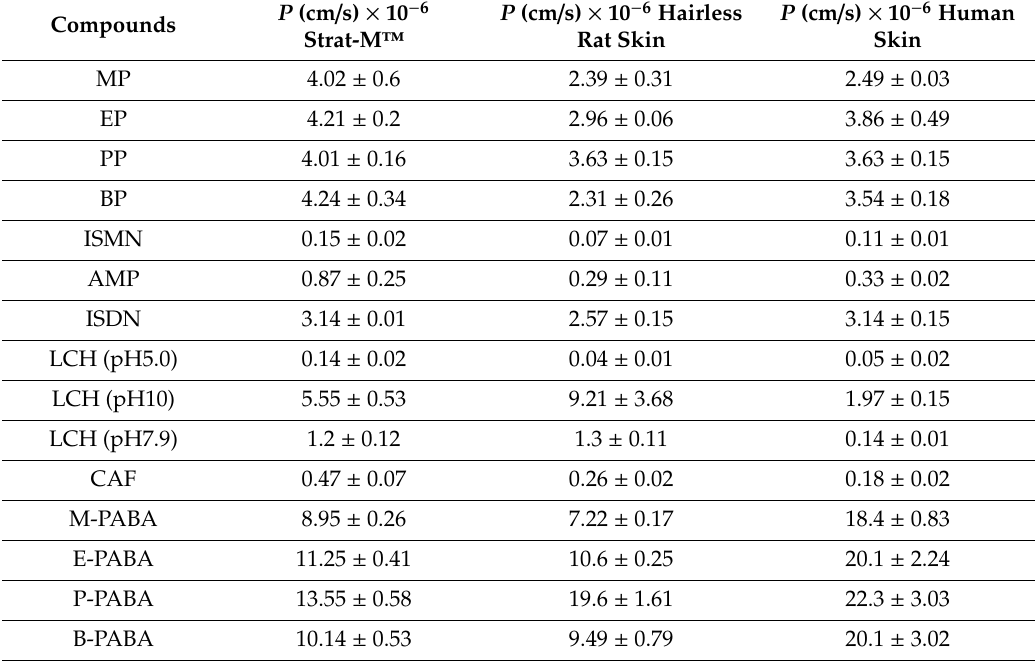
Table 1. Permeability coe ffi cients of chemicals through Strat-M ™ , hairless rat skin, and human skin. Values expressed as mean ± standard deviation (n = 3), Reproduced with permission from Uchida et al.